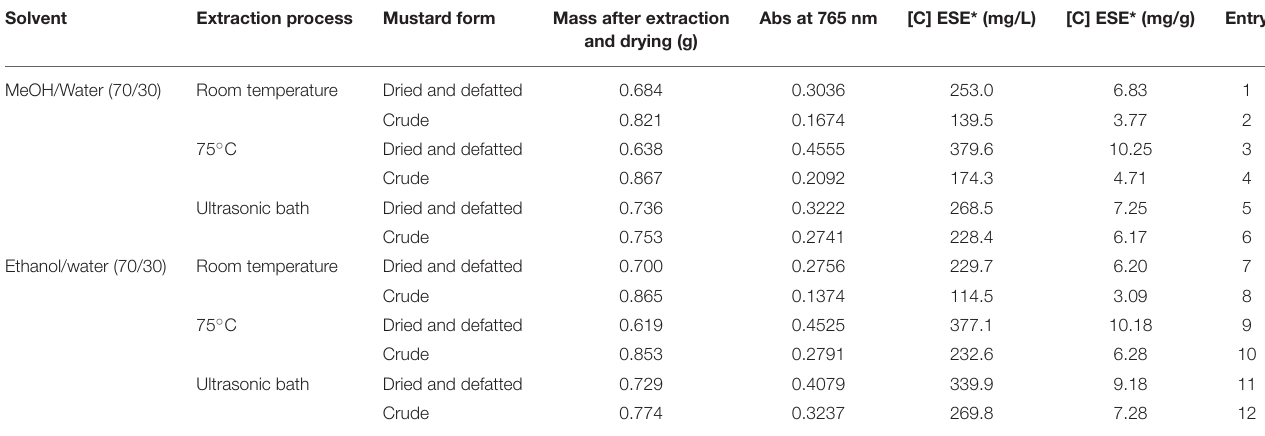
TABLE 2 | Results of the non-optimized extractions performed on mustard residues. Solvent